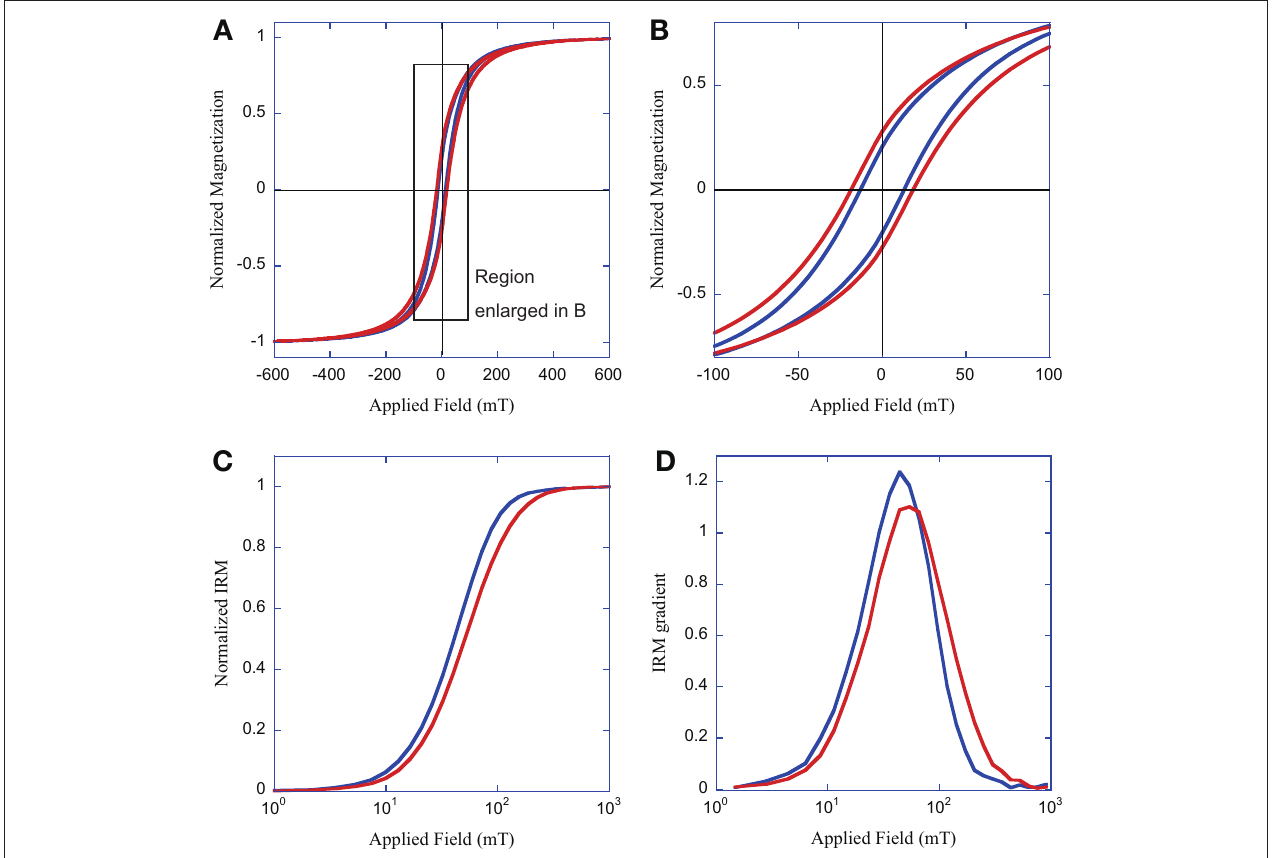
FIGURE 4 | Typical examples of rock magnetic measurements. (A) and (B) Hysteresis curves corrected for paramagnetic slope; (C) IRM acquisition curves; (D) IRM gradient curves (first derivatives of acquisition curves). Red lines are results of sediments at 2540.5 ka representing interglacial component and blue lines are at 2512.5 ka representing glacial component. Diagram B is enlargement of the surrounded region in a box in A.